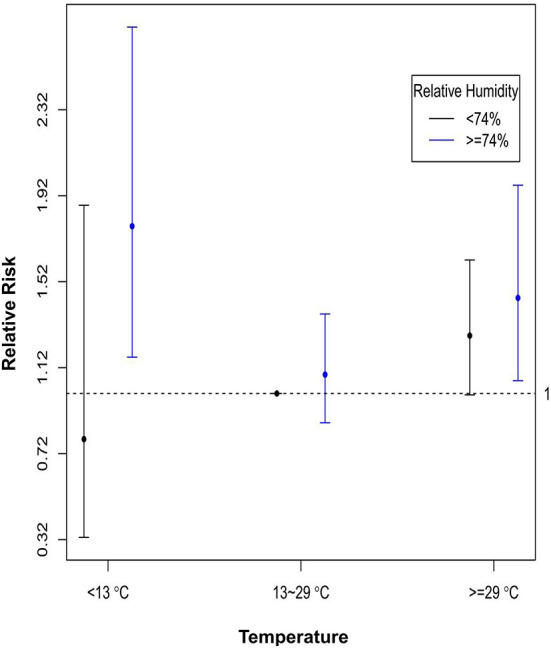
Relative risks of VT incidence of composite conditions of temperature and relative humidity, with modest temperature (13–29°C) and low relative humidity (<74%) as the reference. The dots are the relative risks, and the bars are the corresponding 95% confidence intervals.